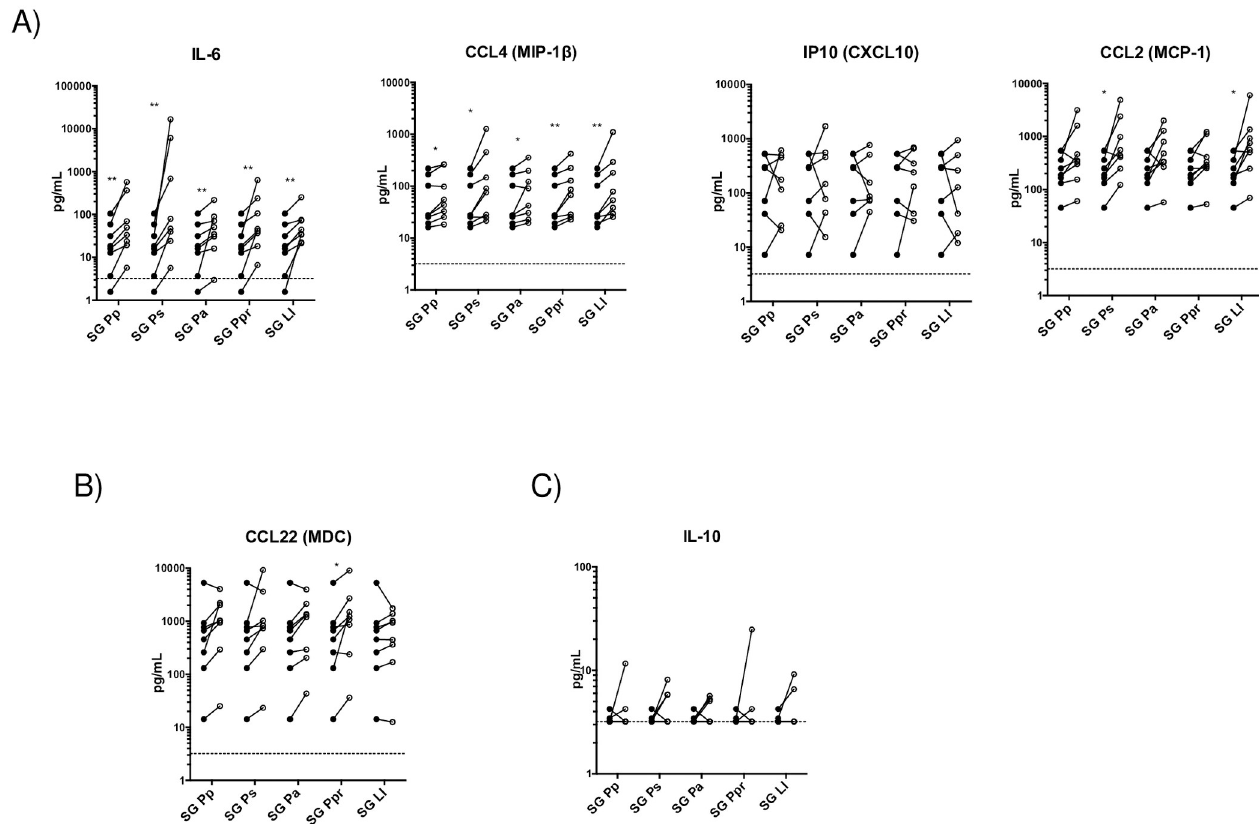
Fig 2. Saliva of several vector species of sand flies upregulates the production of CCL4 and IL-6 in human monocytes. Human monocytes were unexposed (closed circles) or exposed (open circles) to saliva of either SG Pp, SG Pa, SG Ps, SG Ppr, and SG Ll for 24 hours. Supernatants were collected and the levels of A) Type 1-associated chemokines/cytokines IL-6, CCL4, IP10, and CCL2, B) Type-2 associated chemokine CCL22, and C) regulatory cytokine IL-10 were measured. Each line represents an independent donor ( n = 6–8). Statistical difference in cytokine production between unexposed and exposed cells are measured using Wilcoxon matched pairs signed-rank test; � ( p < 0.05); �� ( P < 0.005).